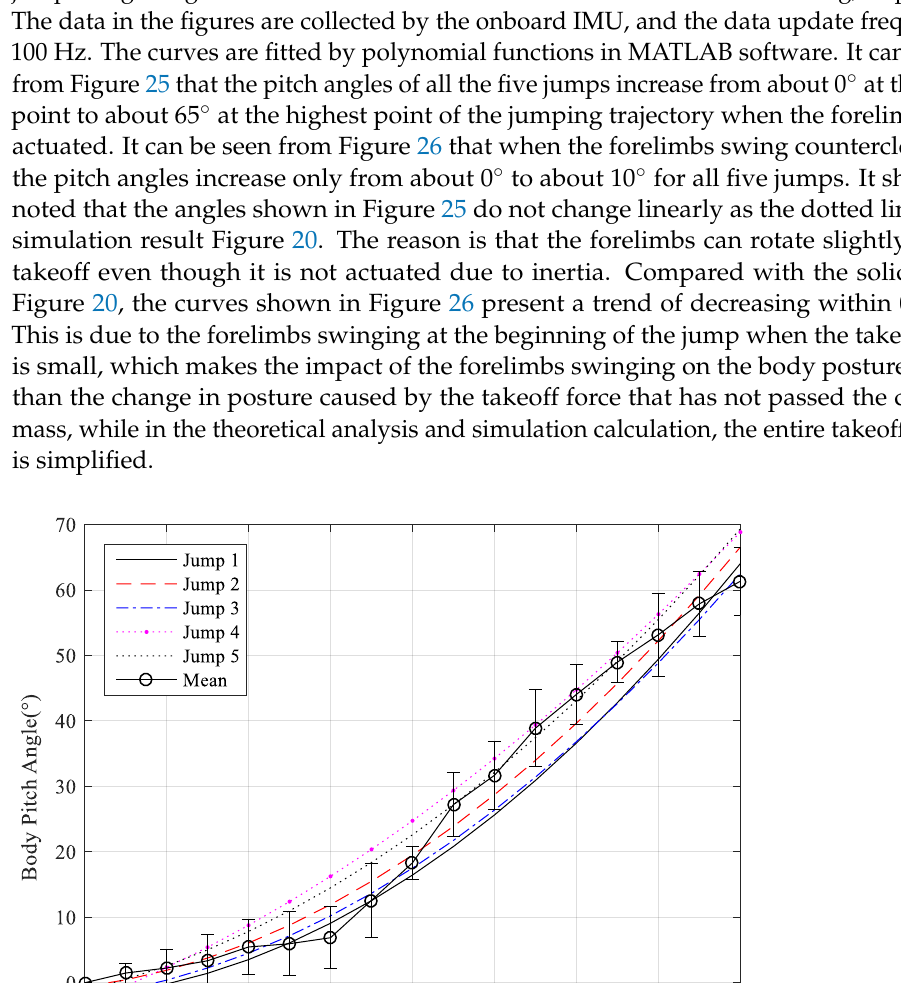
Figure 26. Experimental results for pitching adjustment when the forelimbs are actuated. 6.2.2. The Mode of Jumping for Progress According to the workflow of the mode of jumping for progress, one turn of the pul- ley and 20° of the angle between the body and the ground were taken as the initial state before jumping. The motion sequence of two intermittent jumps is shown in Figure 27. It can be seen from Figure 27 that, the prototype leaves the ground with the velocity of 1.95 m/s and the takeoff angle of 45°; the prototype reaches the highest point of the jump tra- jectory at 0.13 s with the velocity of 1.35 m/s and the height of 10 cm; the prototype makes a smooth landing and completes its first jump at 0.26 s with a jump distance of 38 cm; the prototype enters the preparation stage for next jumping, and it began to drive the winding